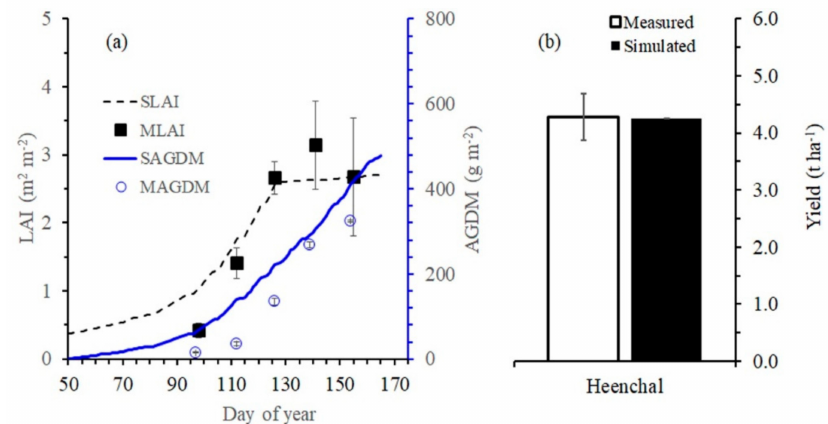
Figure 6. Simulated (S) versus measured (M) leaf area index (LAI) and above-ground dry mass (AGDM) ( a ) and comparison between simulated and measured grain yield ( b ) at Gyeongsang National University, Jinju, South Korea in 2018 for model validation. Vertical bars represent standard deviation of each mean value ( n = 3) at 95% confidence intervals in ( a ) and SE of each mean value ( n = 3) in ( b